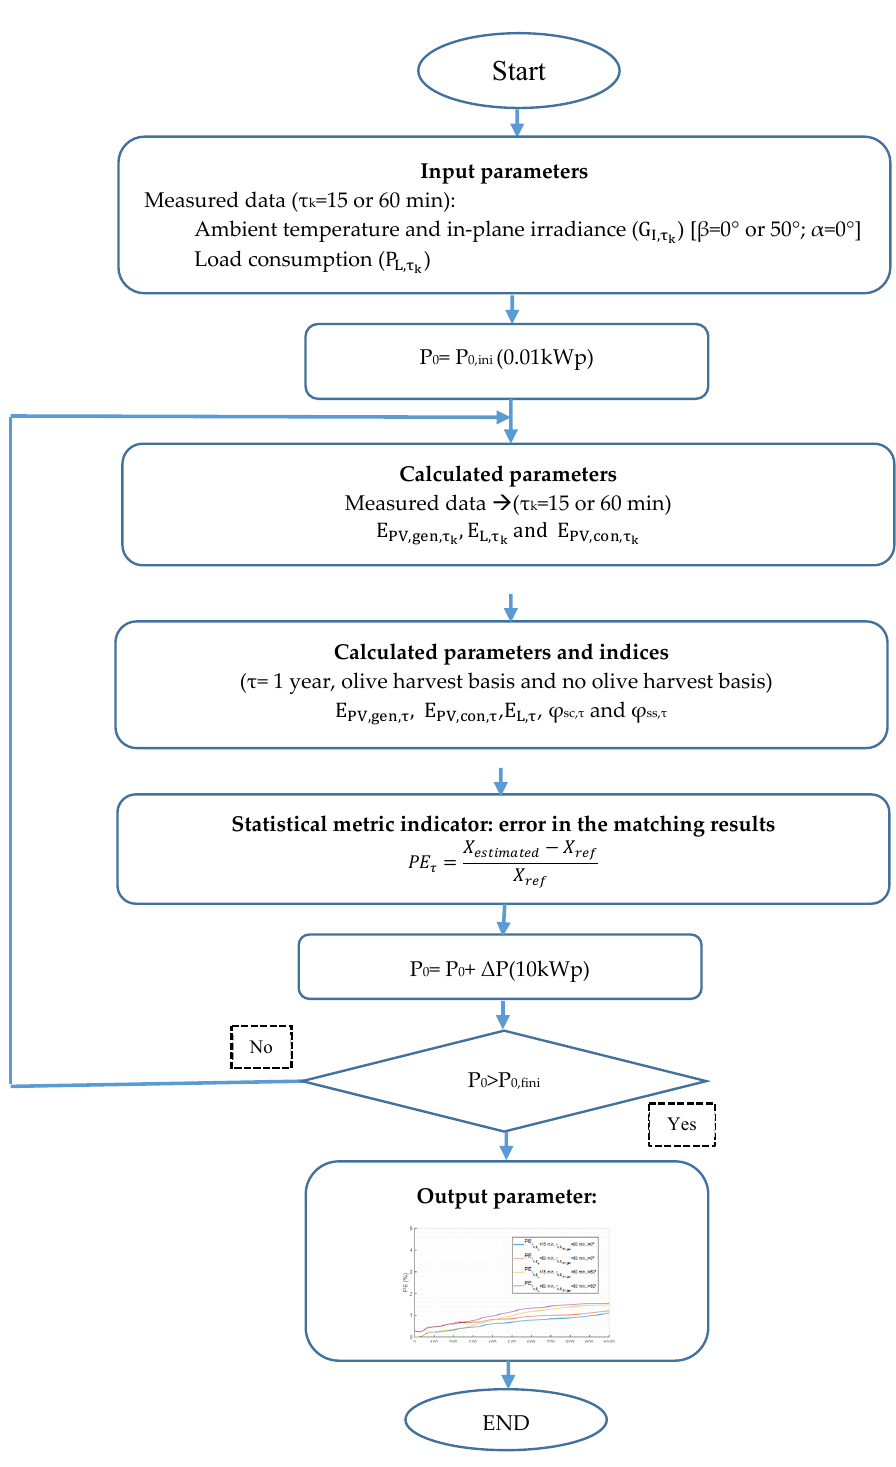
Figure 2. How to estimate the percentage error as function of the nominal array power, P 0 [51,52,64]. ◦ where P 0,fini corresponds to 1000 kWp and β fini has a value of 90 Figure 2 How to estimate the percentage error as function of the n ominal array power, P 0 [51,52,64].